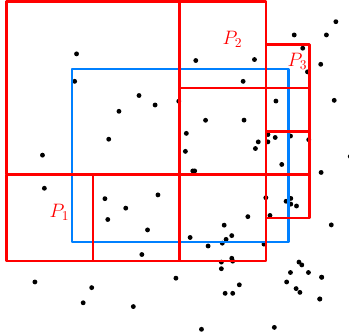
Figure 5. A 2D query sample: leaf nodes selected (red) in the HistTree to match the query window (blue)